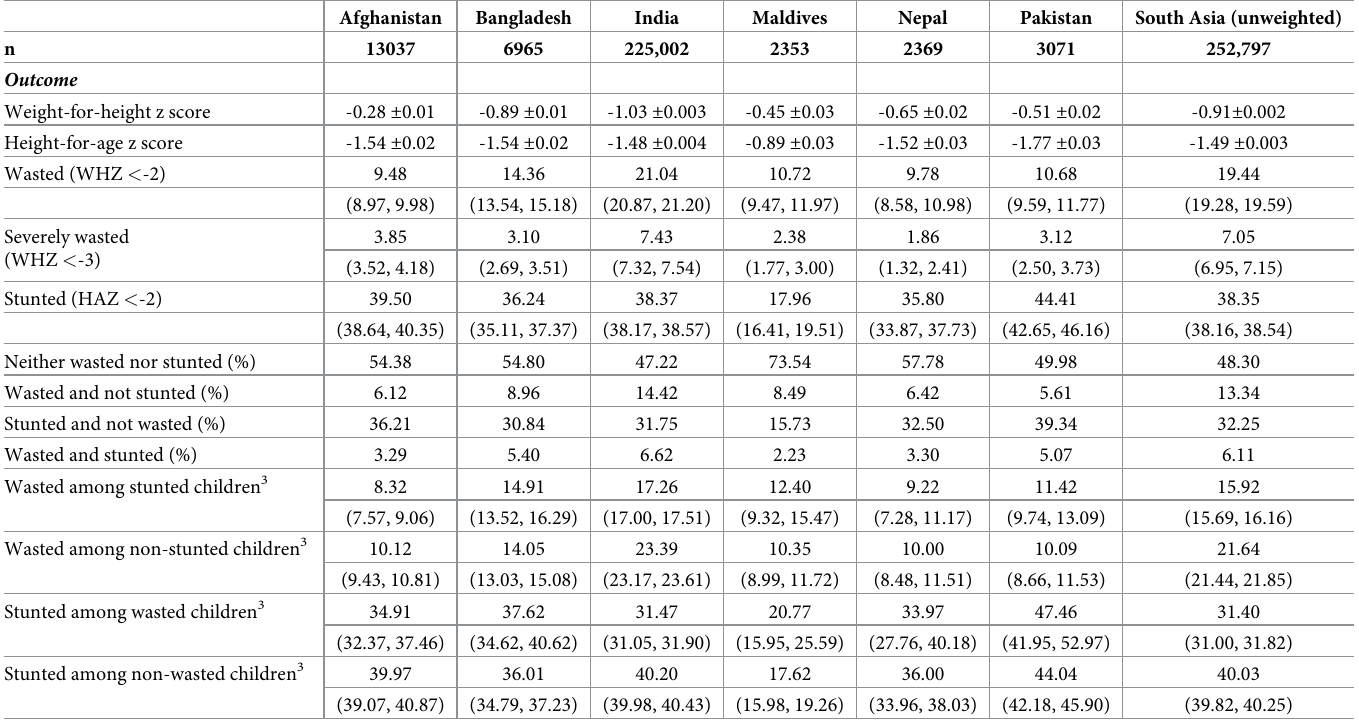
Table 2. Estimates of child anthropometric outcomes 1,2 , by country and